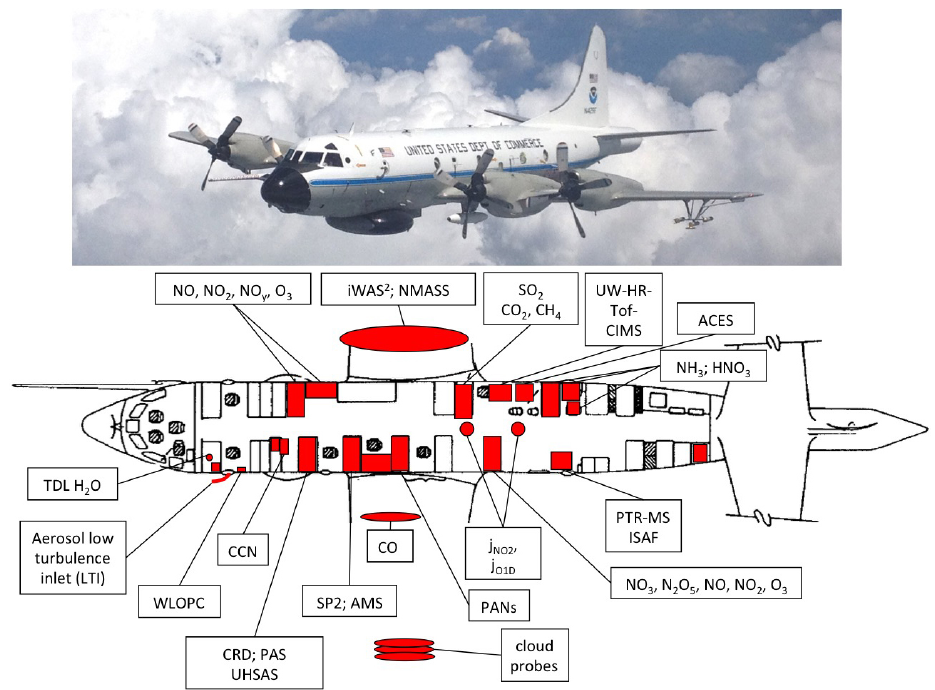
Figure 1. NOAA WP-3D aircraft picture, payload and layout. The photo was taken during the inter-comparison flight with the NCAR C-130 by Lynne